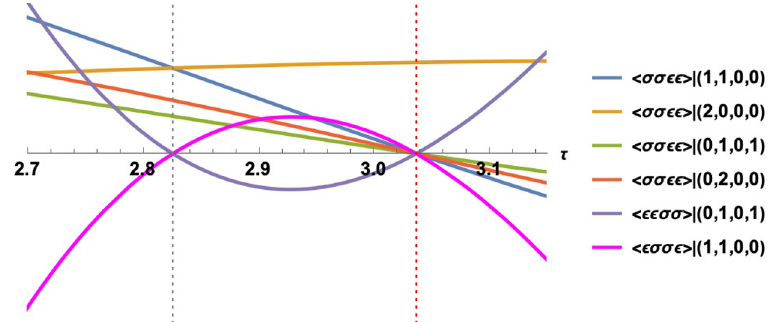
functionals for even Z operators at J = 0 near 2 k ;1 | 34 + 2 (red vertical dotted line) σ